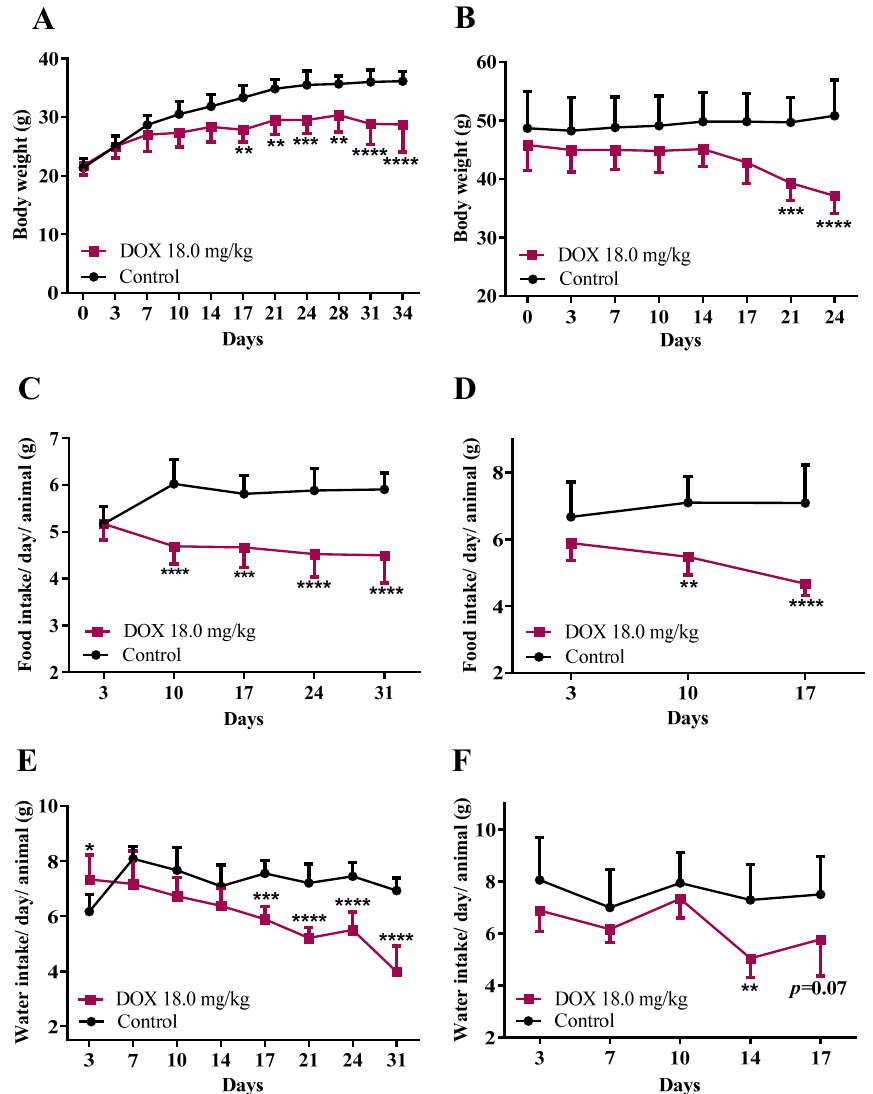
Figure 2. Body weight, food and water intake in infant and adult mice exposed to a cumulative dose of 18.0 mg/kg DOX (pink squares) compared with controls (black circles). Body weight in ( A ) infant and ( B ) adult mice. Food consumption of ( C ) infant and ( D ) adult mice. Water consumption of ( E ) infant and ( F ) adult mice. Results are presented in grams (g) of food intake/day/weight of animal, mL of water intake/day/weight of the animal or g of body weight, and as means ± standard deviation (SD), from 6 infant or 7 adult mice per group. Statistical comparisons were made using a two-way ANOVA followed by the Sidak’s post hoc test (** p < 0.01, *** p < 0.001, and **** p < 0.0001, DOX 18.0 mg/kg vs.